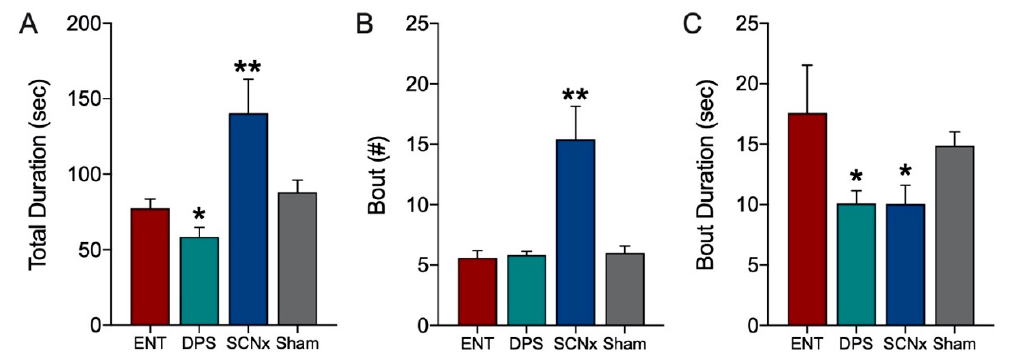
Figure 5. SCN lesions had no effect on total power in delta and theta bands during one day of object exploration. Power spectrum during exploration was similar among SCNx (n = 5) and Sham (n = 3) animals compared to ENT (n = 12) and DPS (n = 12) groups ( A ), however, peak theta frequency was ~1.0 Hz slower; for this reason, the theta band was defined as 4–7 Hz for SCNx and Sham groups. Total power in the delta ( B1 ) and theta ( B2 ) frequency bands, as well as in the T/D ratio ( B3 ) did not differ among all four groups. Data expressed as mean (±SEM).